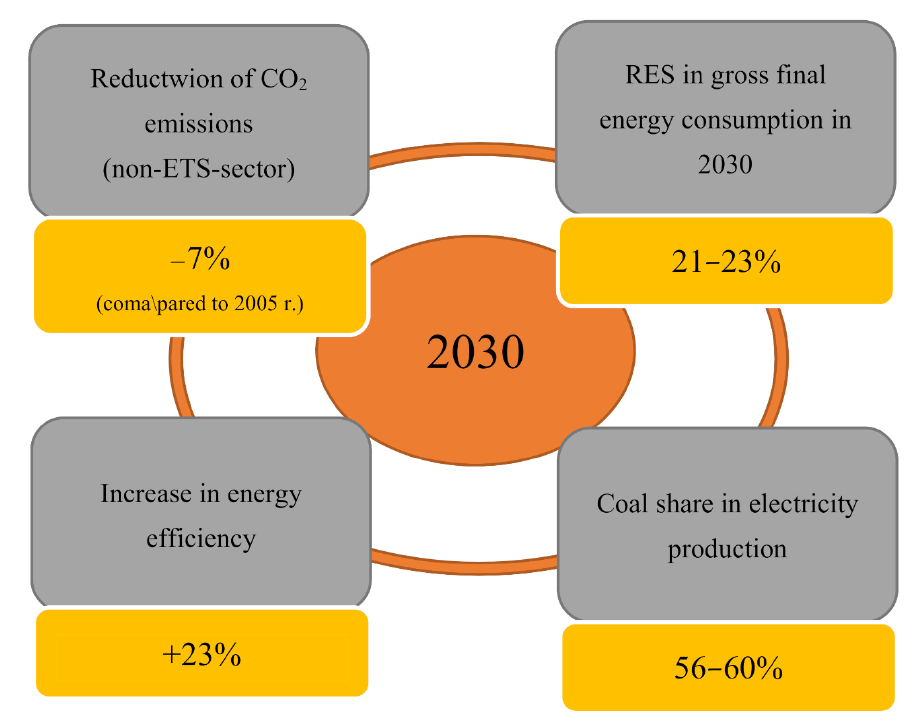
Figure 5. 2030 goals of the National Energy and Climate Plan for the years 2021–2030 for Poland. Source: developed by the authors, based on Reference